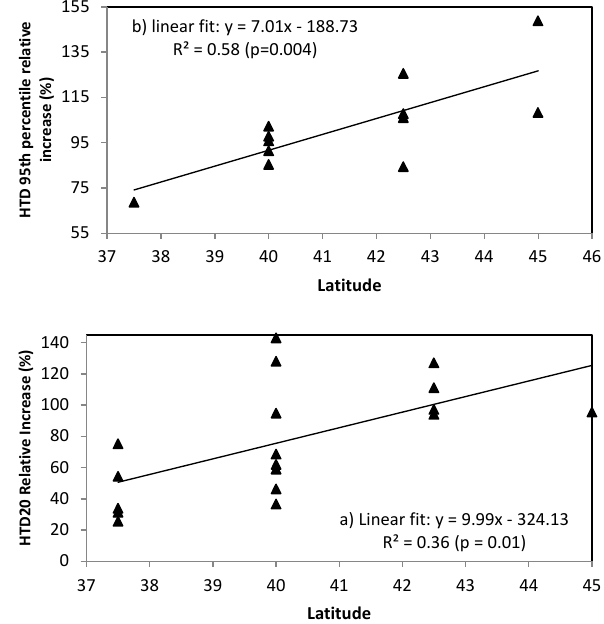
Figure 5. Linear regression testing relationship between latitude and percent change (relative increase) in the number of days with an air temperature at 850hPa higher than (a) 20 ◦ C (HTD 20 ) and (b) exceeding the 95th percentile at 850hPa in the June–September period from 1978 to 2012. Only sites where significant temporal changes were identified were included in the analysis. HTD 22 . 5 did not change consistently with